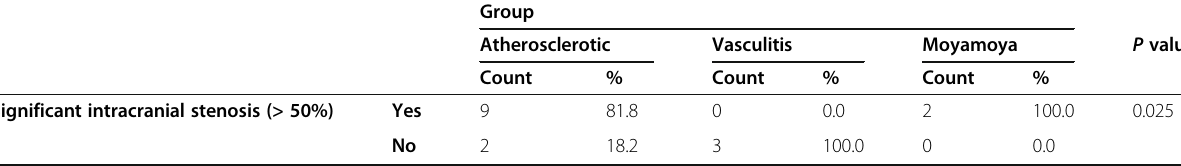
Table 2 Comparison between groups regarding significant intracranial stenosis